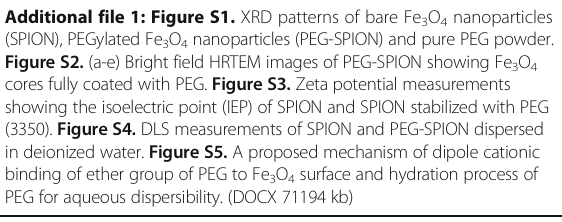
Figure S2. (a-e) Bright field HRTEM images of PEG-SPION showing Fe 3 O 4 cores fully coated with PEG. Figure S3. Zeta potential measurements showing the isoelectric point (IEP) of SPION and SPION stabilized with PEG (3350). Figure S4. DLS measurements of SPION and PEG-SPION dispersed in deionized water. Figure S5. A proposed mechanism of dipole cationic binding of ether group of PEG to Fe 3 O 4 surface and hydration process of PEG for aqueous dispersibility. (DOCX 71194